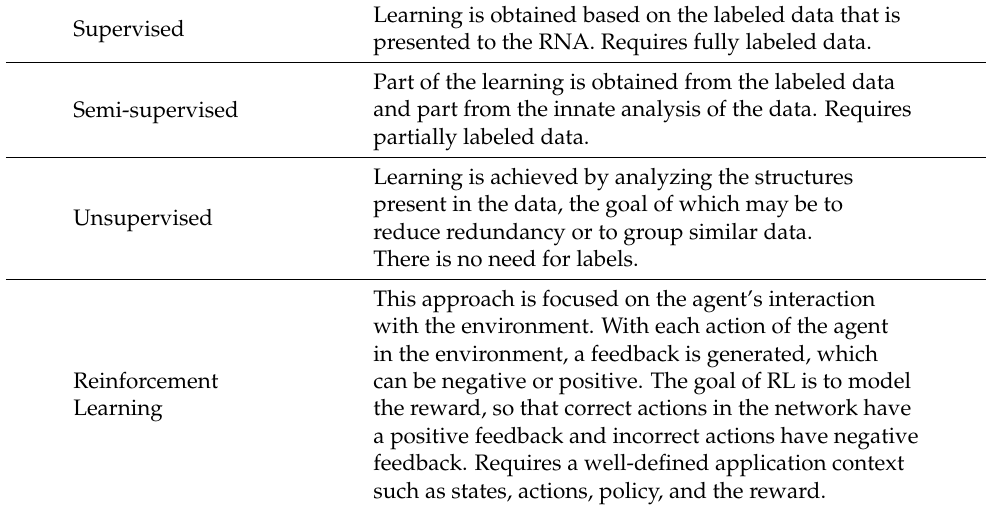
Table 1. Summarization of learning